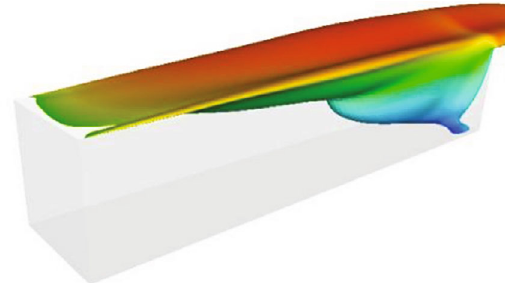
Figure 3: Isosurface of 10% k streamwise velocity).